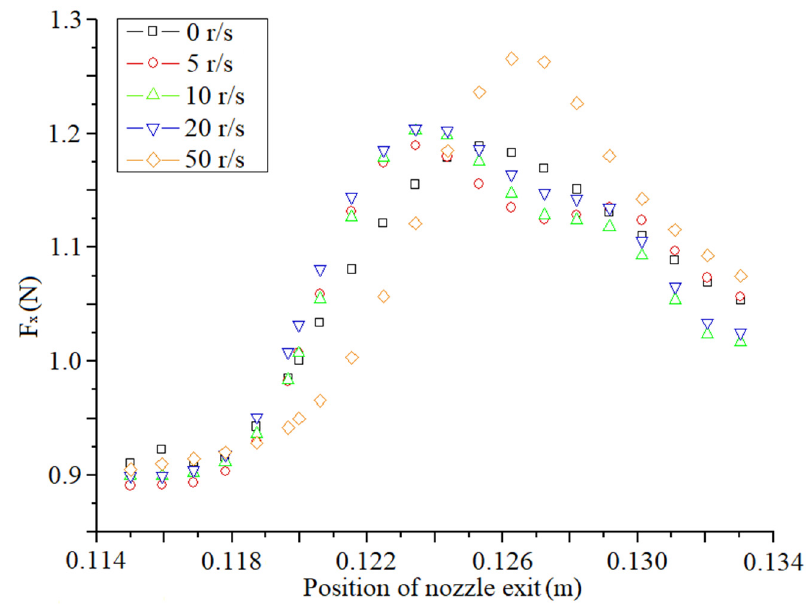
Figure 22. Thrust distribution along the left nozzle exit at different rotational angular velocities.